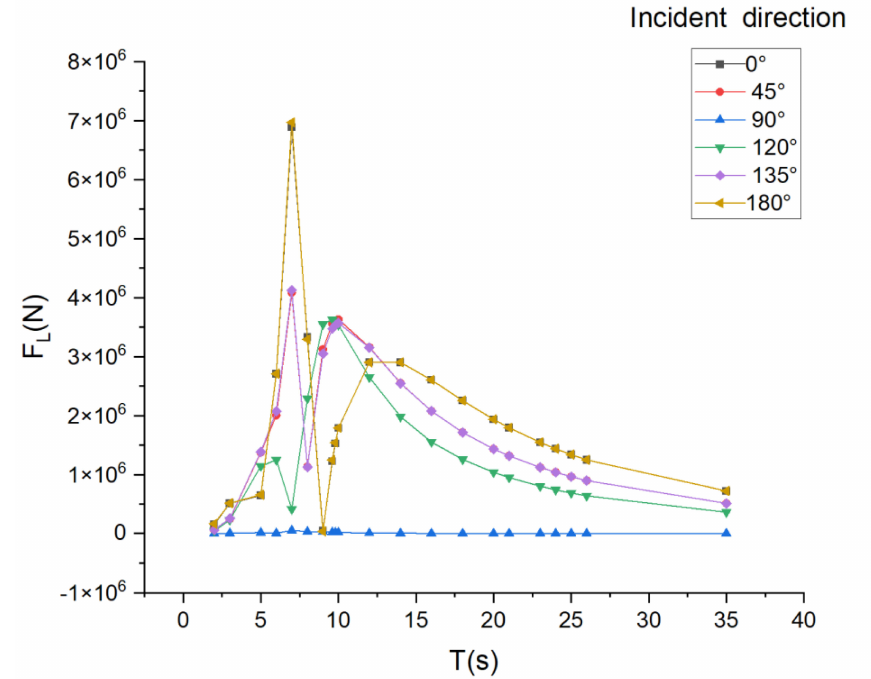
Figure 5. RAO of longitudinal force.